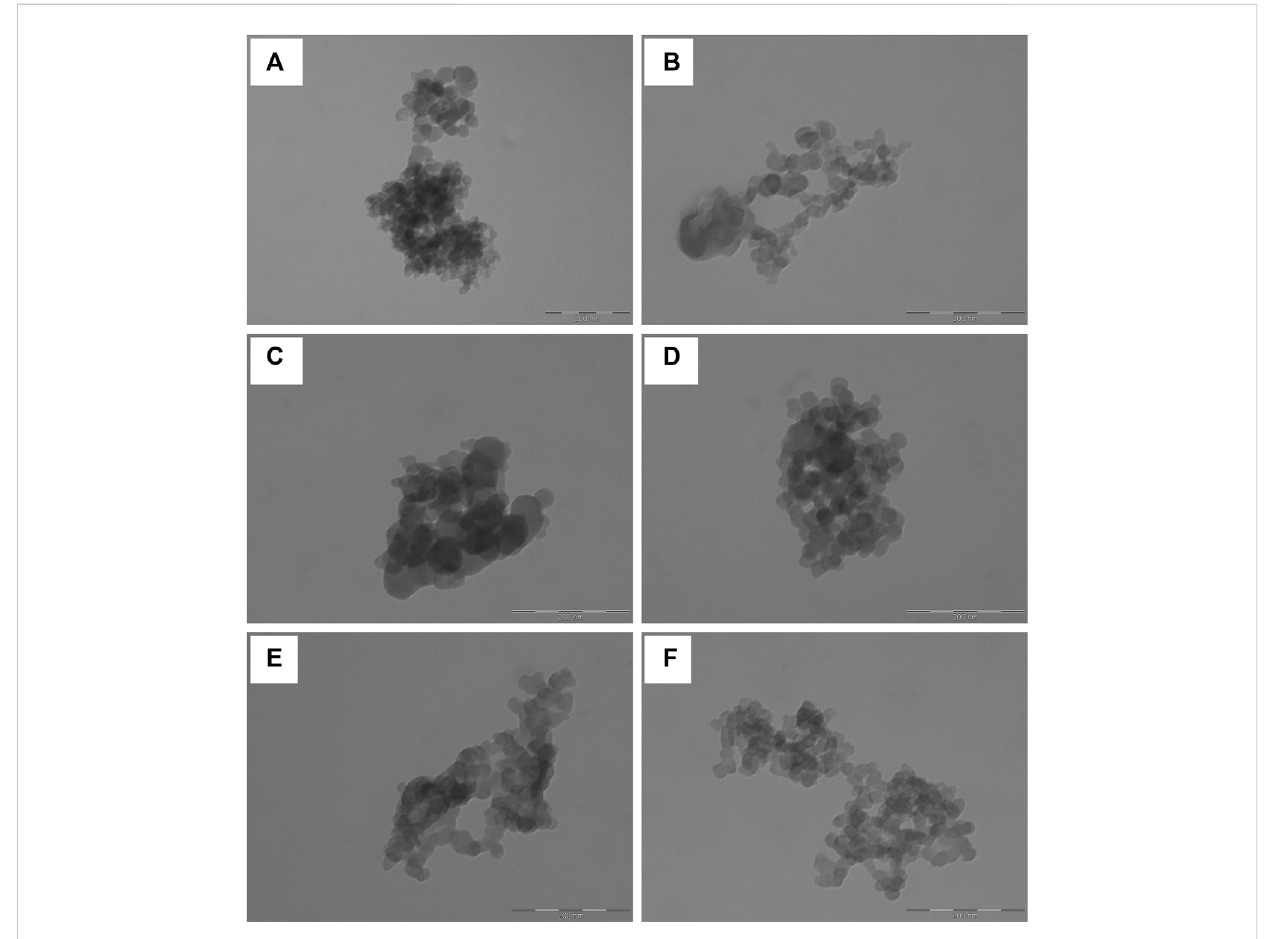
FIGURE 3 Representative TEM images of sericin nanoparticles obtained dispersing NP (A and B) , NPS (C and D) and NPMix (E and F) in deionized water. The scale bar is 200 nm.